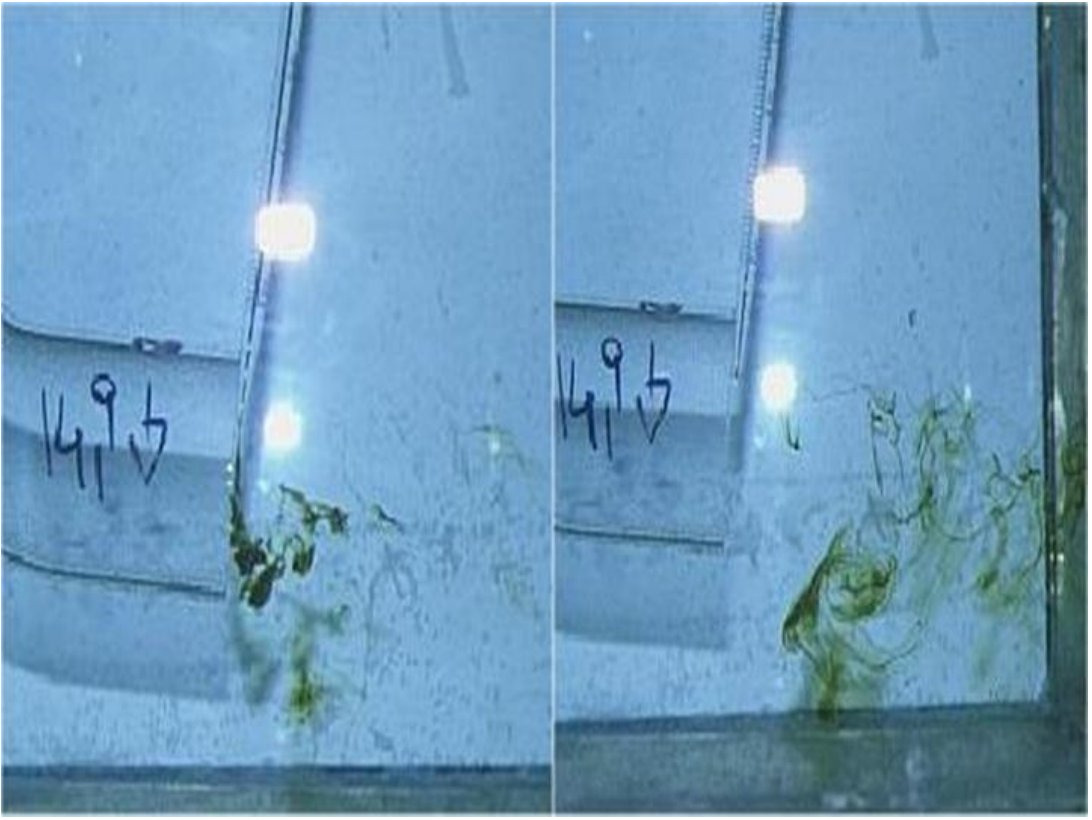
Figure 4. Turbulence test for the mini-MODUS exit mouth. Using a pipette (which can be seen in both frames), a few dye drops were put just in front of the mini-MODUS exit (water out) in order to make the water flow detectable. The influence of the water flow due to the air lift pumping was localized only very close to the mouth. The water results unaffected in the immediate proximity below the mouth. The figure shows no disturbance of the sediment at 9 L min − 1 water flow. The time elapsed between these two frames (shot from left to right) was half a second.